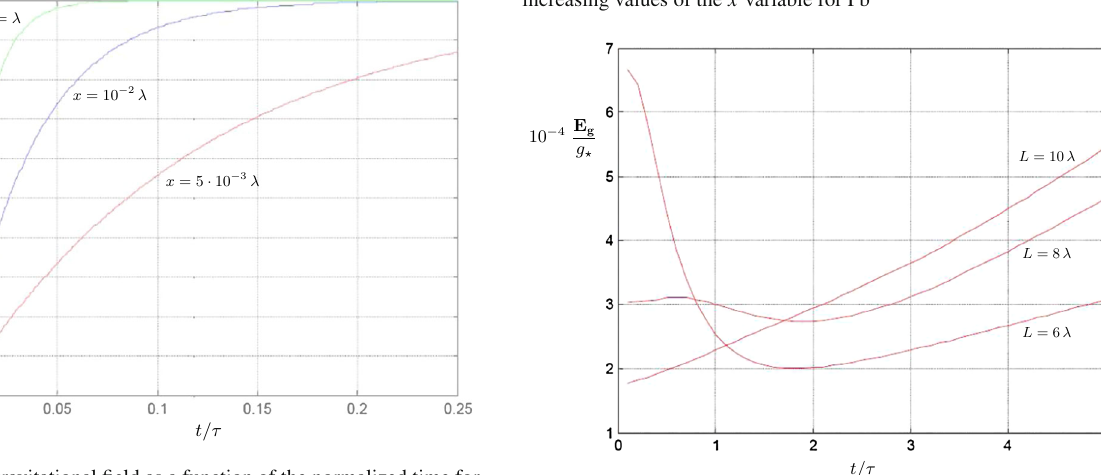
Fig. 2 The gravitational field as a function of the normalized time for increasing values of the x variable for YBCO